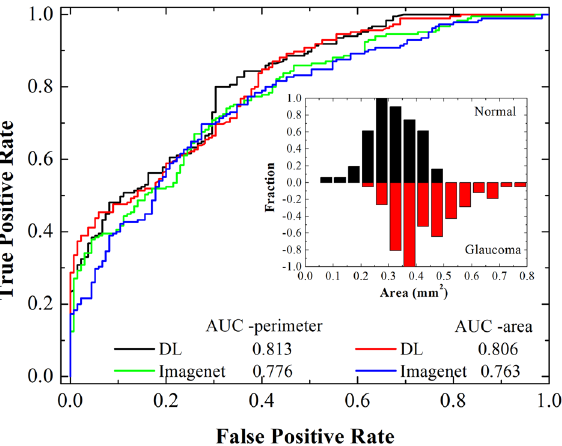
Figure 11. ROC curves obtained from logistic regression of perimeter and area among normal and glaucoma subjects. On a same dataset, deep learning has higher discrimination ability for glaucoma as compared to commercial software. Inset shows the distribution of FAZ area among the normal and glaucoma